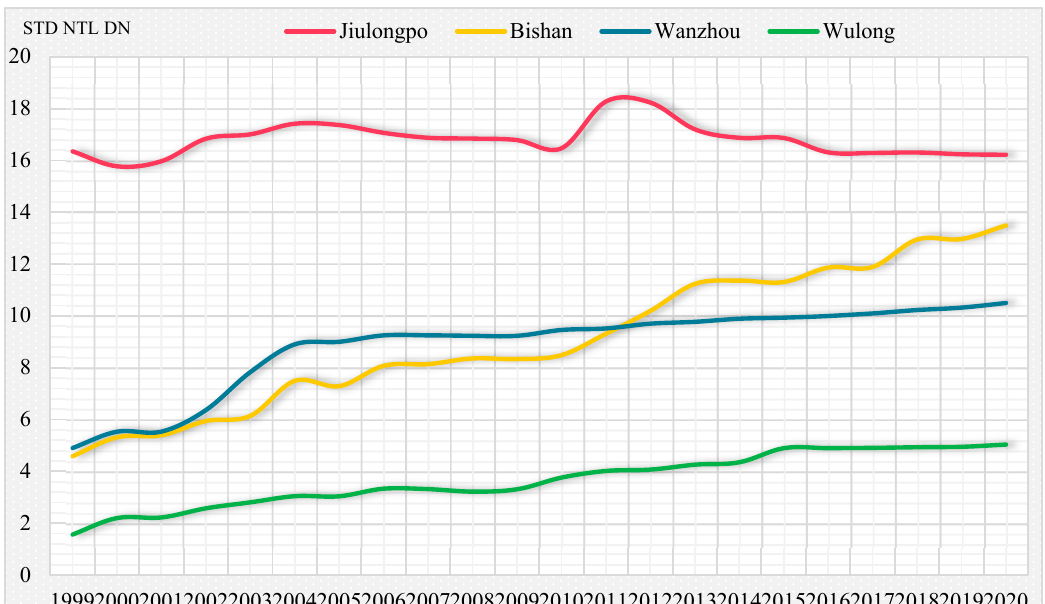
Figure 16. Variation of NTL standard from 1999 to 2020 for four suburban district zones.